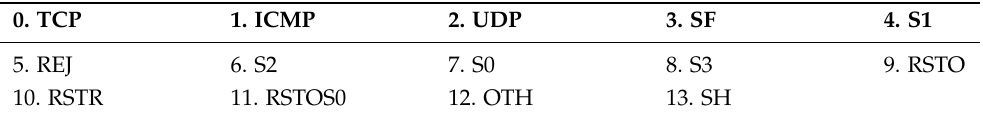
Table 1. Protocol types and connection statuses used to create our grounding. The Knowledge Base will contain a set of rules based on